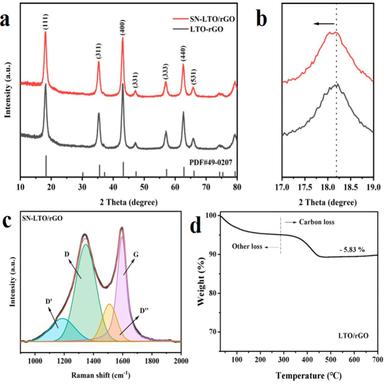
(a) XRD patterns of LTO/rGO and SN-LTO/rGO; (b) Amplified view of the (111) lattice planes of LTO/rGO and SN-LTO/rGO; (c) Raman spectra of SN-LTO/rGO; (d) TG curve of LTO/rGO.